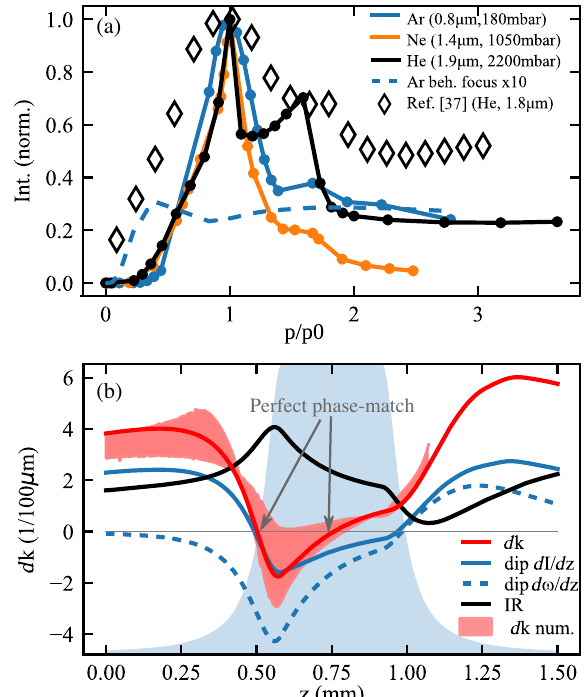
FIG. 4. Simulated high-harmonic generation dynamics in the tight focusing regime for different wavelengths and gases. (a) Normalized far-field XUV flux in the cutoff region versus normalized pressure for a 1.75-cycle pulse at 800 nm in argon (solid blue line, p 0 ¼ 180 mbar, 75 – 95 eV, w 0 ¼ 20 μ m), at 1400 nm in neon (solid orange line, p 0 ¼ 1050 mbar, 250 – 320 eV, w 0 ¼ 35 μ m), and 1900 nm in helium (solid black line, p ¼ 2000 mbar, 560 – 700 eV, w ¼ 47 . 5 μ m). Here, the target 0 0 is positioned in front of the focus. The flux in argon for a gas target positioned after the focus is shown as a dashed blue line (upscaled by a factor 10). We compare the helium simulations to the data from Ref. [37] (open diamonds). (b) Different contri- butions to the total phase mismatch (thick red line) on axis for the most intense XUV burst for argon at p ¼ p 0 calculated by Eq. (2): The phase-mismatch IR is due to the propagation of the laser driving pulse (black line), dip; dI=dz and dip; and d ω =dz from the HHG dipole caused by the change of laser intensity (solid blue line) and the blueshift of the laser pulse (dashed blue line), respectively. Moreover, the numerically calculated total phase mismatch within the half-cycle of the XUV burst is shown as the red shaded area. The blue shaded area indicates the gas pressure